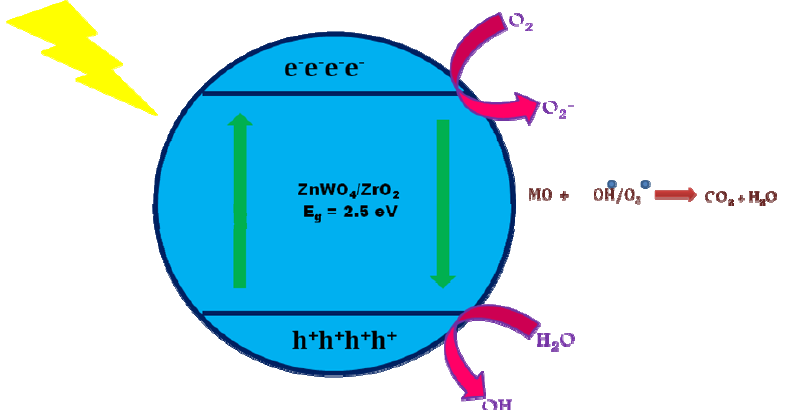
Fig.12. Mechanism of ZnWO